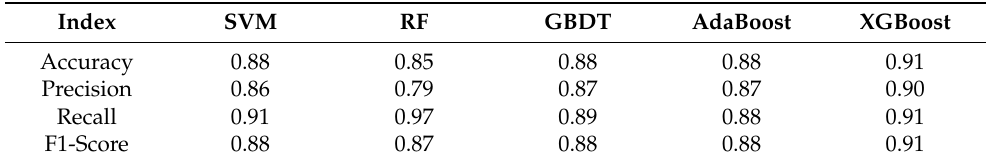
Table 2. Performance measure indices of the five models based on the same parameters of the training and test